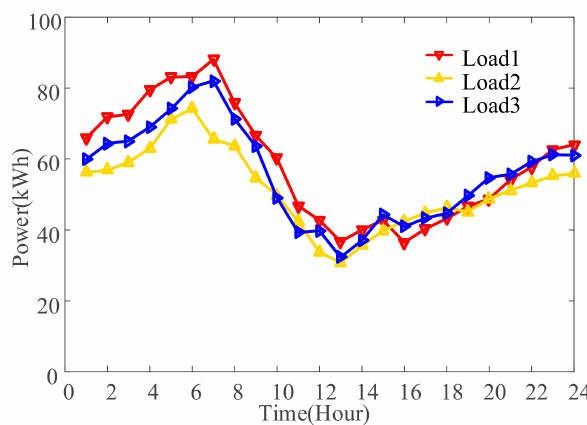
Figure 2. PV and electric load demands.